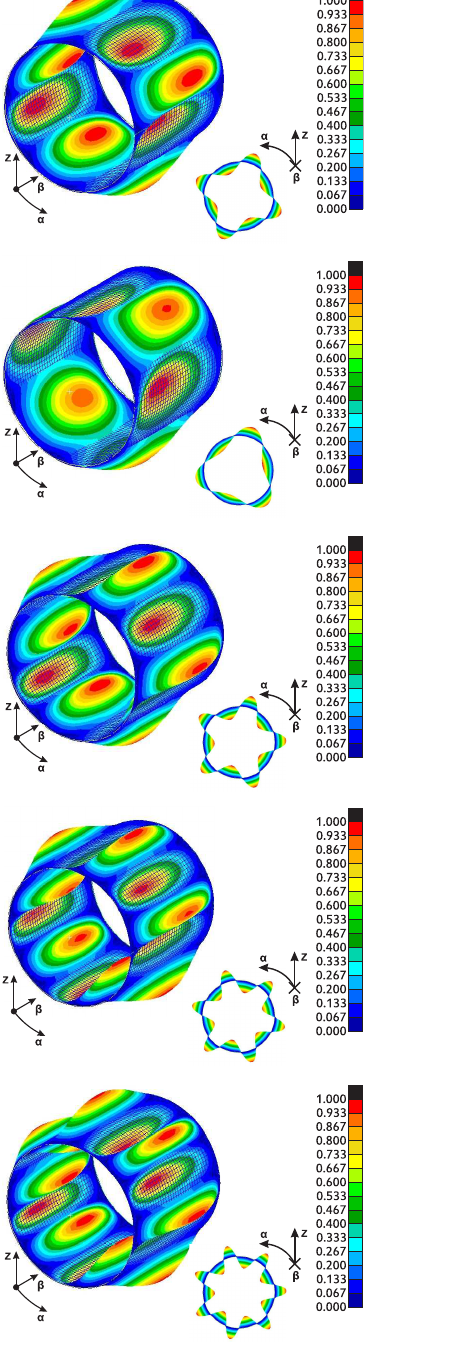
verse anisotropy is confirmed by Figure 15 where the first five frequencies with w≠0 obtained by the 3D exact model exhibit an important zigzag behavior for displace- ment components through the thickness. The cylinder